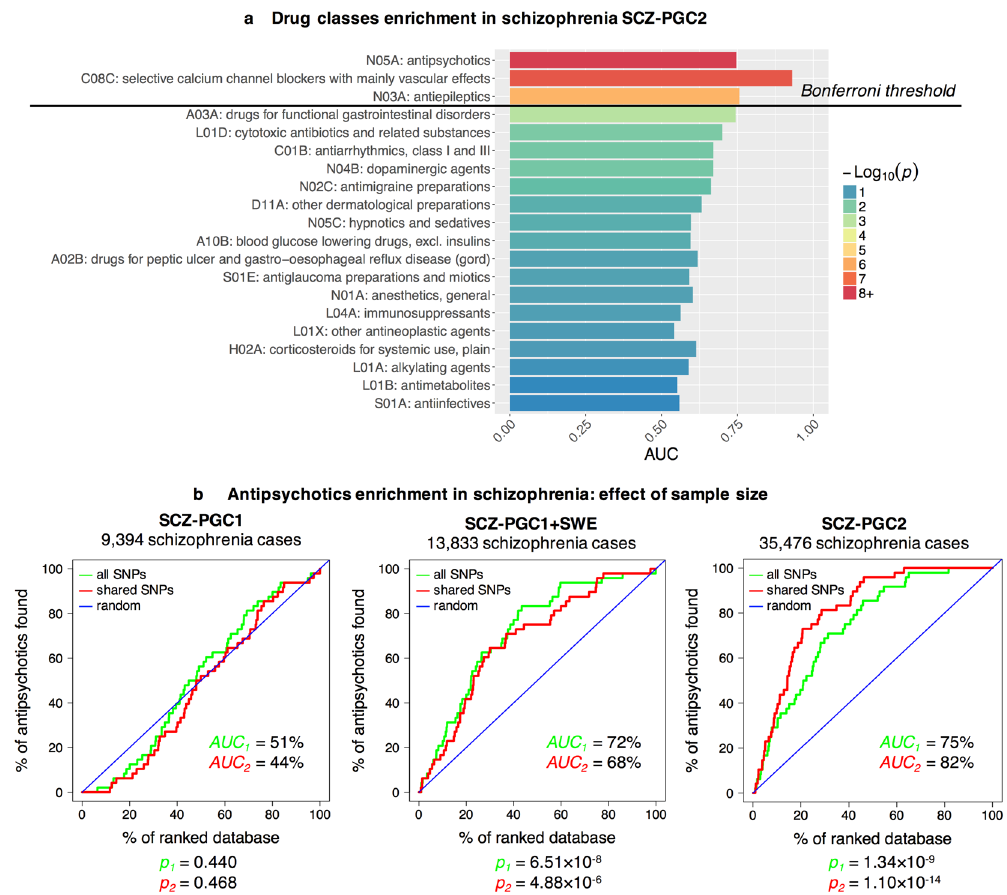
Figure 3. ( a ) Enrichment of top ATC drug classes in SCZ-PGC2 GWAS. AUC is the area under the enrichment curve, and p-values are derived from Wilcoxon-Mann-Whitney’s test, which assesses whether drugs of a given class have a higher association with schizophrenia than expected by chance. (b) Antipsychotic enrichment in schizophrenia GWASs as a function of sample size. The figure shows enrichment curves for antipsychotics (ATC code N05A), using three GWASs with increasing sample sizes. The expected “random” enrichment curve is indicated in blue. The red enrichment curve is based on SNPs shared between the three studies, and the green enrichment curve uses all SNPs available in a study. Corresponding areas under the curve (AUC) and p-values ( p ) are